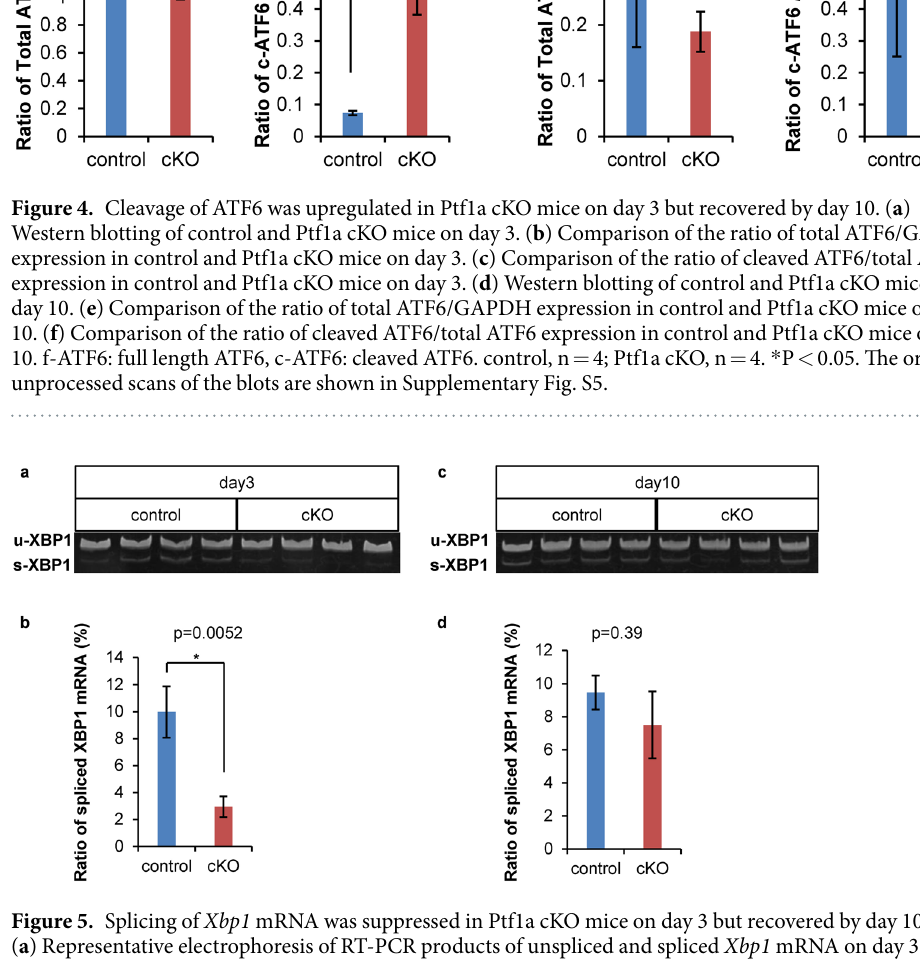
ulation plays a role. The precise mechanism including the identification of responsible signals warrants future investigation.